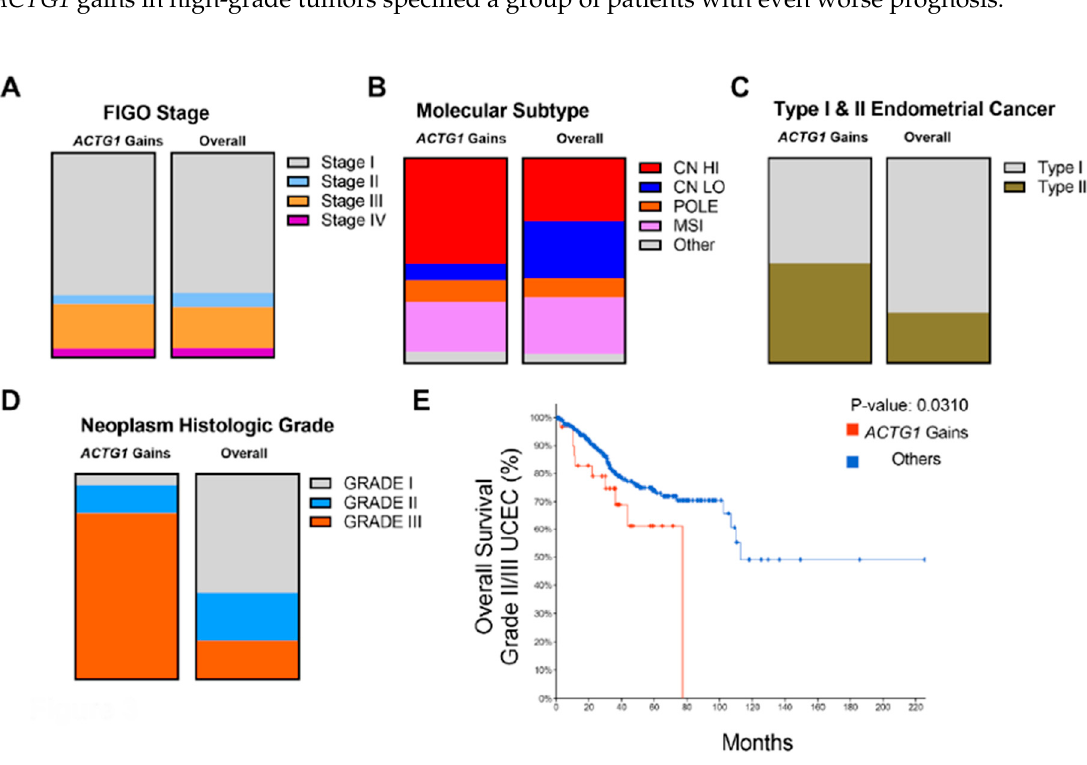
2 Figure 3. Distribution of ACTG1 gains in uterine corpus endometrial carcinoma (UCEC). ( A ) Stages